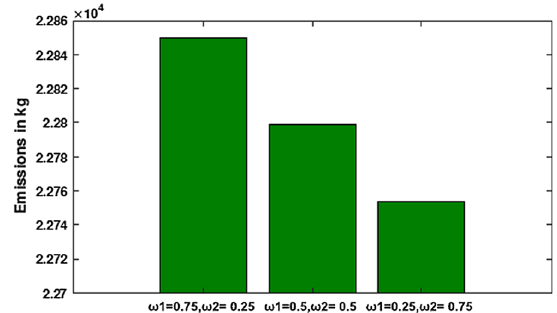
Fig. 7 Impact of ω 1 and ω 2 on emission of network